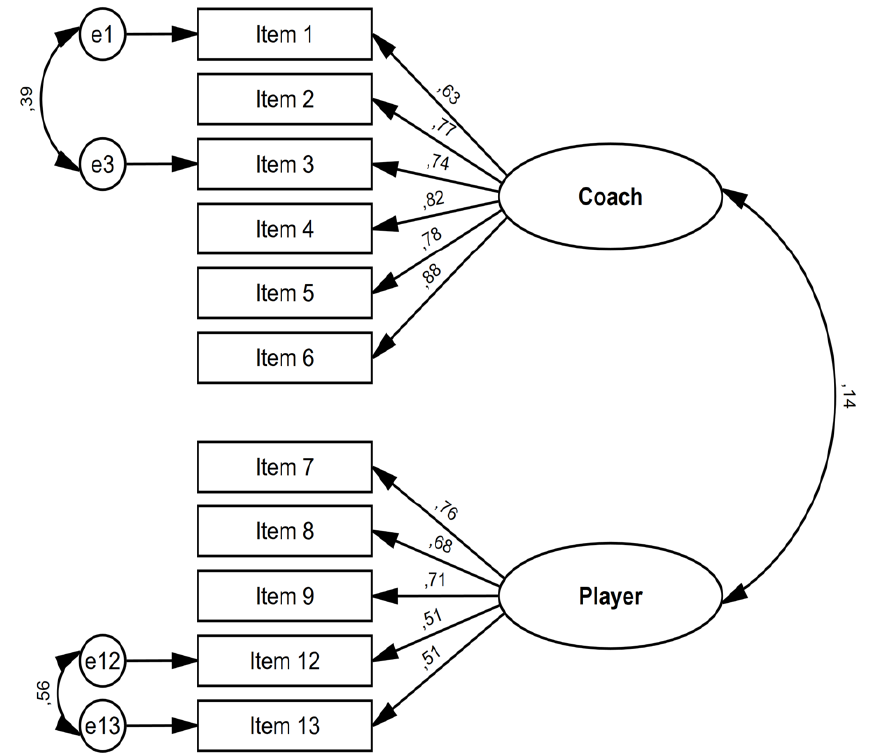
Figure 1. Confirmatory factor analysis for the Negative Factors A ff ecting Players’ Well-being